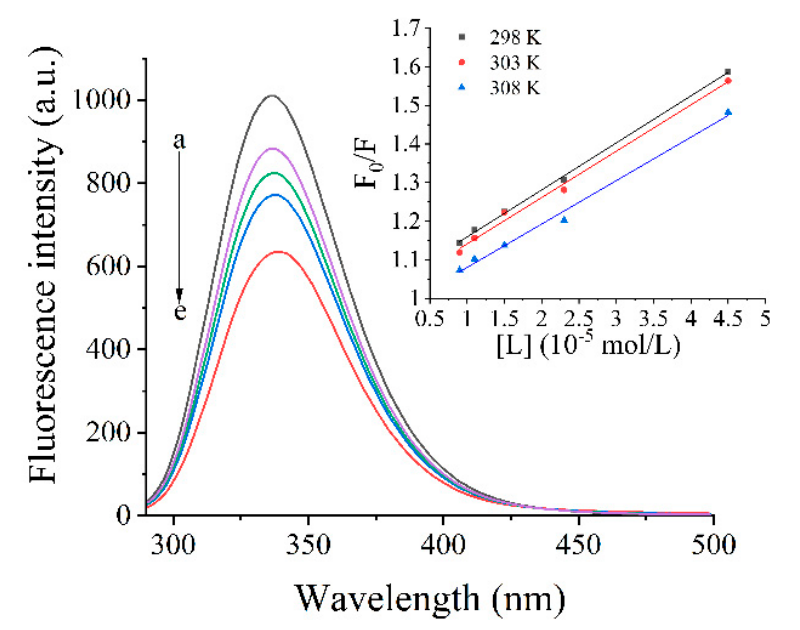
Figure 5. Fluorescence emission spectra of PGWP-SIF systems in 10 mM PB pH 7.4. a–e, PGWP, PGWP-SIF-A, PGWP-SIF-B, PGWP-SIF-C, PGWP-SIF-D. The Stern–Volmer plots for the quenching of PGWP by SIF at different temperatures.